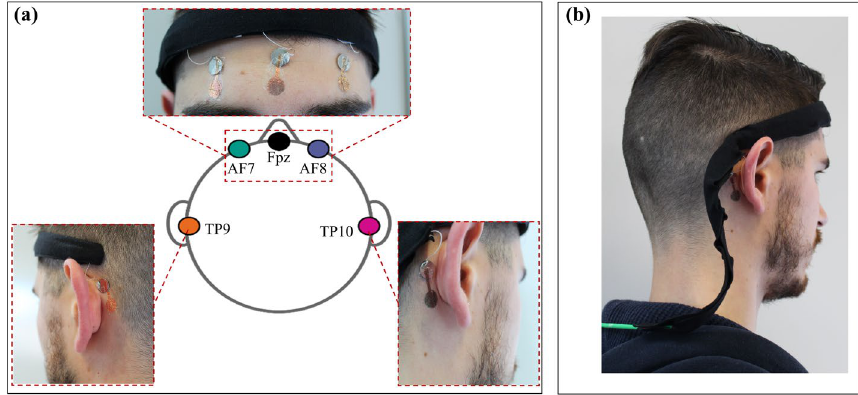
Figure 2. ( a ) Tattoo-electrodes are positioned following the 10–10 system, where the electrode in position Fpz is used as reference. The high conformability ensures a really good and high-quality contact with the skin, even in complex positions such as the mastoid process (electrode positions TP9 and TP10). ( b ) Rear view of the headset with the connector. The custom PCB is positioned on the back of the